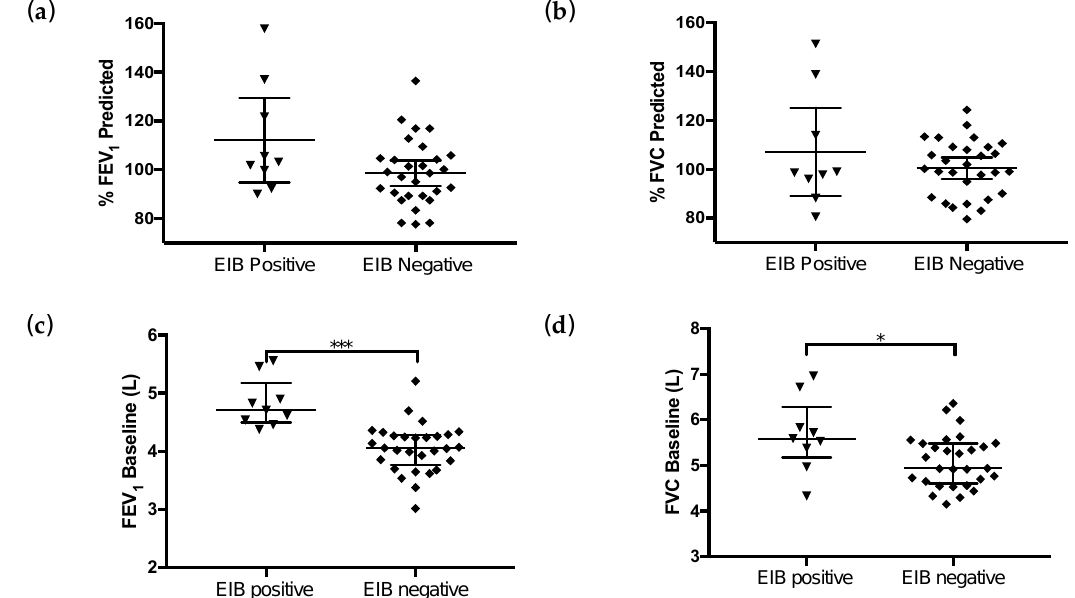
Figure 2. Comparison between groups of baseline values of: ( a ) % predicted FEV1 ( p = 0.09); ( b ) % predicted FVC ( p = 0.93); ( c ) FEV1 ( p ≤ 0.001); ( d ) FVC ( p = 0.02). * < 0.05 and *** < 0.001. VO 2 max , on the other hand, was significantly lower in EIB+ subjects (Figure 3), whereas the values obtained in the lactate threshold were similar.